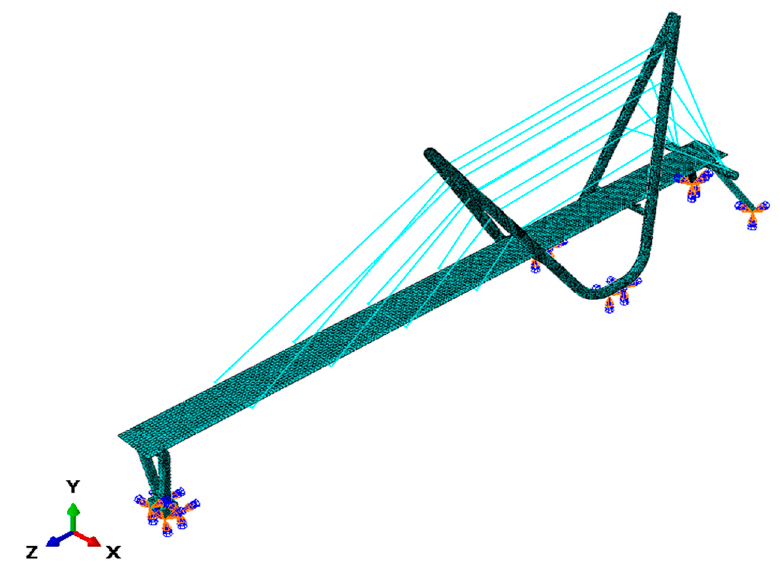
Figure 2. The FE (finite element) model of the three-span cable-stayed footbridge.